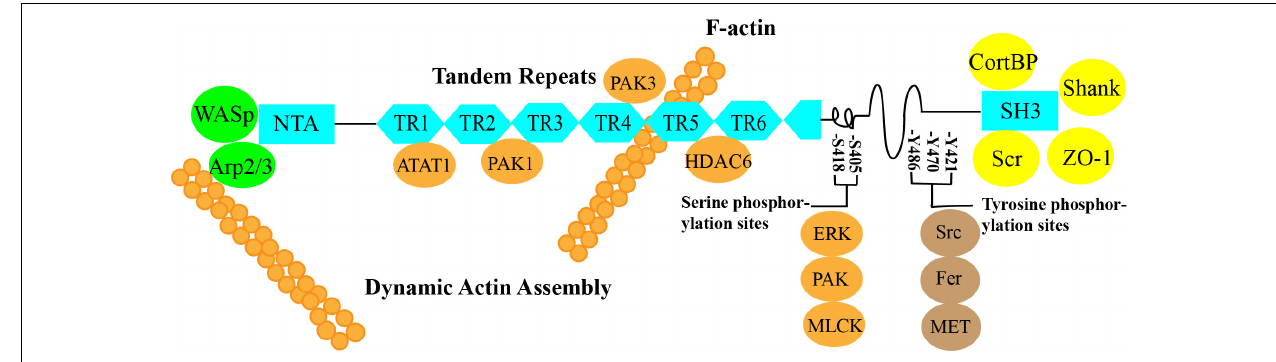
FIGURE 1 | (cid:192) N-terminal acidic region (NTA): The NTA of cortactin binds to Arp2/3 alone or cooperates with Wiskott–Aldrich syndrome protein (WASP) to bind Arp2/3 to regulate branched actin assembly and regulate F-actin polymerization and contraction (Weed et al., 2000; Takehito et al., 2001; Weaver et al., 2002; Pant et al., 2006). (cid:193) Cortactin function can be regulated by posttranslational modifications of the 6.5 F-actin repeat domain, which contains a repeating 37-amino acid sequence. These modifications include phosphorylation and acetylation by PAK1, PAK3, ATAT1, and HDAC6 (Ohoka and Takai, 1998; van Rossum et al., 2003, 2005; Katsube et al., 2004; Zhang et al., 2007; Castro-Castro et al., 2012; Hayes et al., 2013; Li et al., 2017). (cid:194) SH3: The C-terminal domain allows actin to function as a scaffold protein because many cytoskeletal, membrane transport, and signaling proteins are bound to the C-terminal SH3 domain, such as ZO-1, CortBP, and Shank (Weed et al., 1998; Weed and Parsons, 2001; Burkhardt et al., 2008). (cid:195) The central part of the protein between the F-actin repeat domain and the SH3 domain contains an α -helix and a proline-rich region that includes three tyrosine phosphorylation sites, Y421, Y470, and Y486 (human), which are phosphorylated by Src, Fer, and c-Met. The two serine phosphorylation sites, S405 and S418, are phosphorylated by ERK, PAK, MLCK, and other kinases (Beaty et al., 2013; Rosse et al., 2014; Moshfegh et al., 2015).